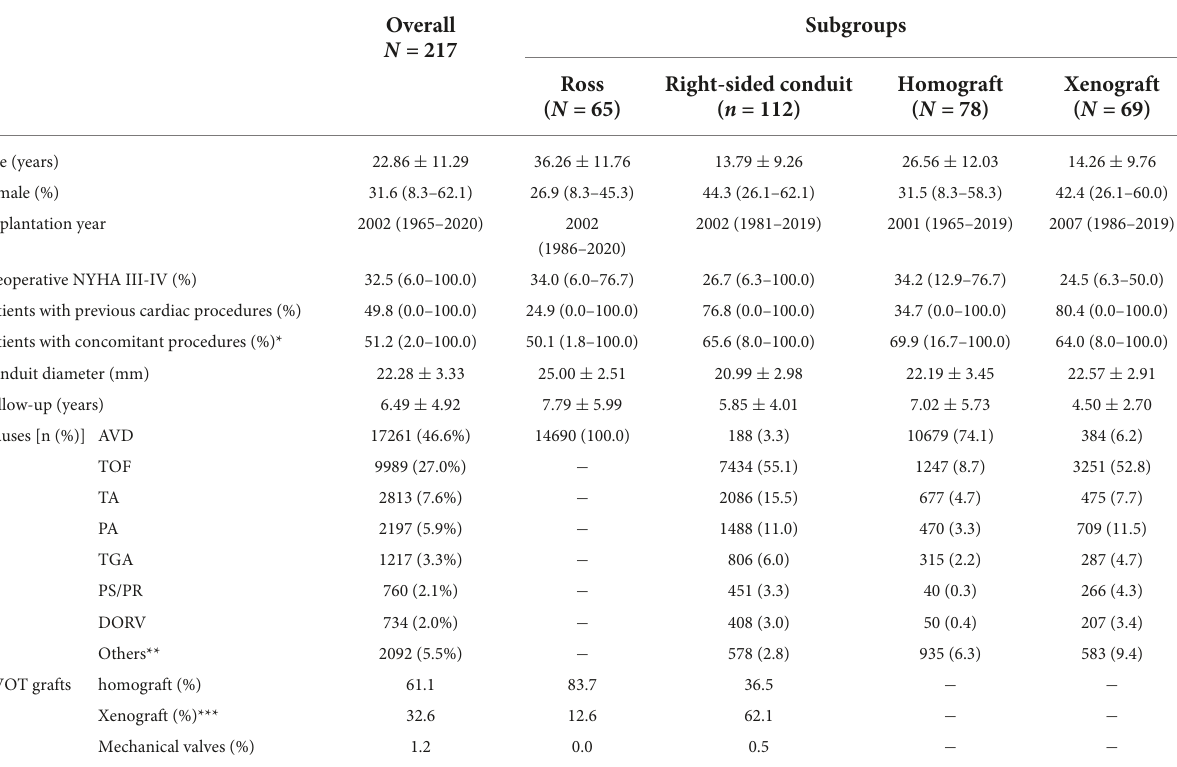
TABLE 1 Pooled baseline